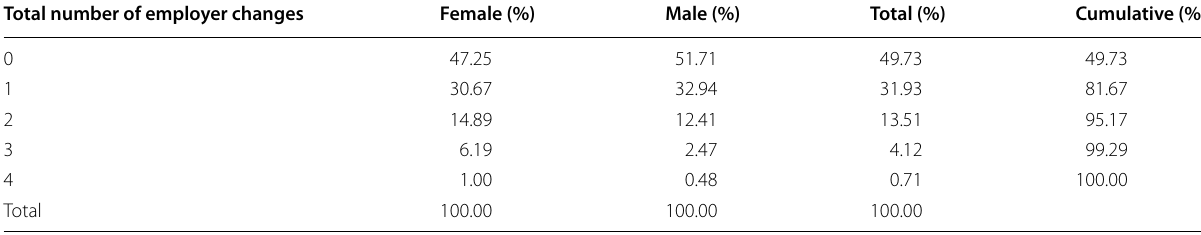
Table 4 Final number of employers by gender. Source BAP 2005/06, author’s calculations